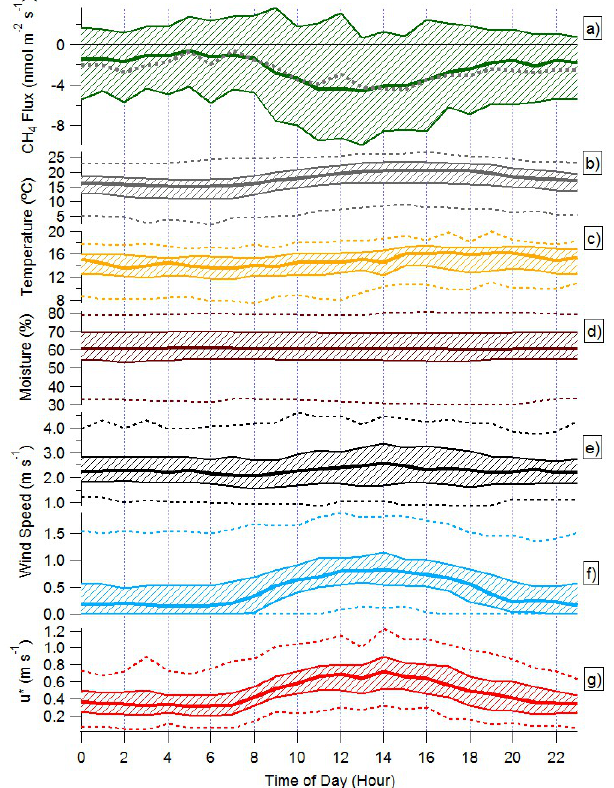
Fig. 7. Median (bold) diurnal cycle of CH 4 fluxes with average flux (dashed gray) (a) , ambient temperature (b) , soil surface temperature (c) , soil moisture (d) , wind speed above canopy (e) , mid-canopy (f) , and friction velocity, u ∗ (g) ; with interquartile range (shaded area), and the 5th and 95th percentile range (indicated by dashed